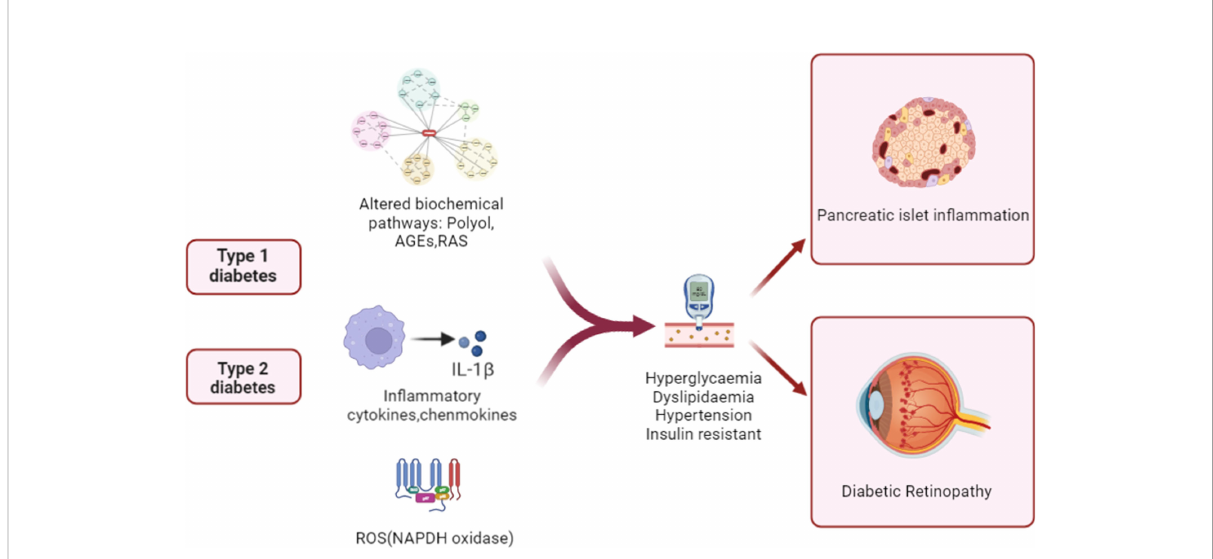
FIGURE 1 Schematic illustration of pathogenic mechanisms leading to pancreatic b cell damage and sight-threatening endpoints of diabetic retinopathy (DR). In patients with diabetes, in fl ammation, aberrant signaling of trophic factors, and biochemical pathways are upregulated. The alterations then enter the systemic circulation and contribute to diabetic pathology and islet in fl ammation by increasing levels of blood glucose and lipids and insulin